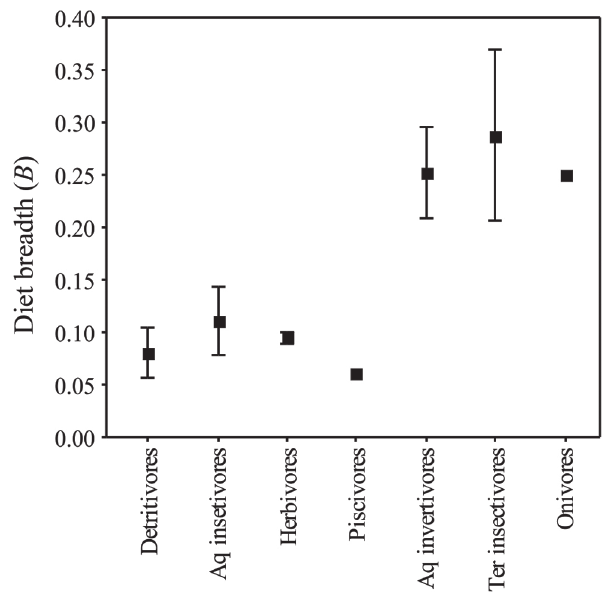
Fig. 4. Mean ± standard error of diet breadth ( B ) of fish trophic guilds in the Vermelho River, East Atlantic basin, Antonina, Paraná State, Brazil. Aq = aquatic; ter = terrestrial. Piscivores and omnivores are not included in the ANOVA.